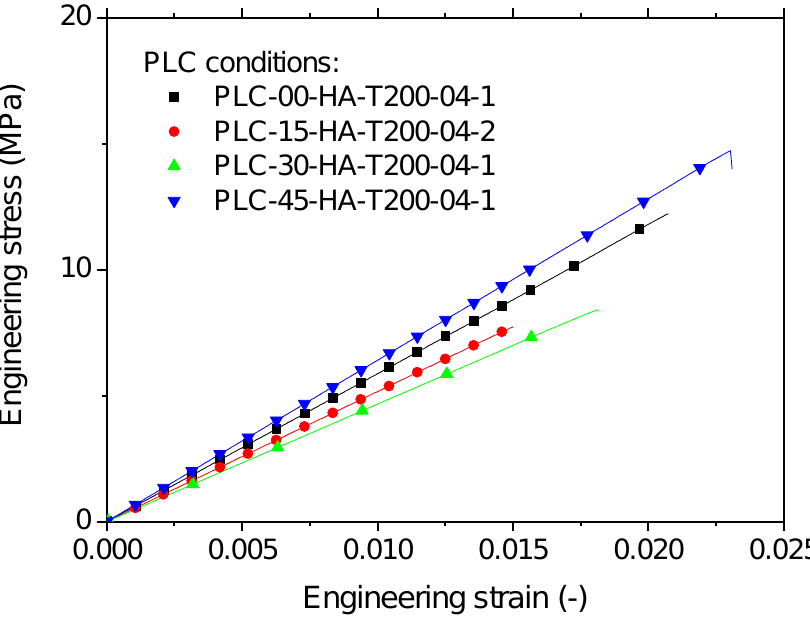
Figure 10. Tensile response of PLC printed using vertical orientation (HA) for various printing angles ranging from 0 up to 45°.